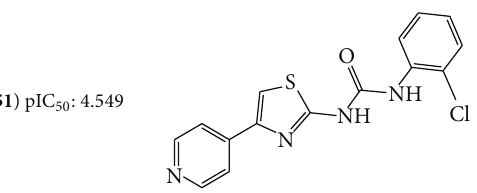
Figure 6: Structure of the 51 pyridylthiazole analogous compounds and their pIC 50 values [20].